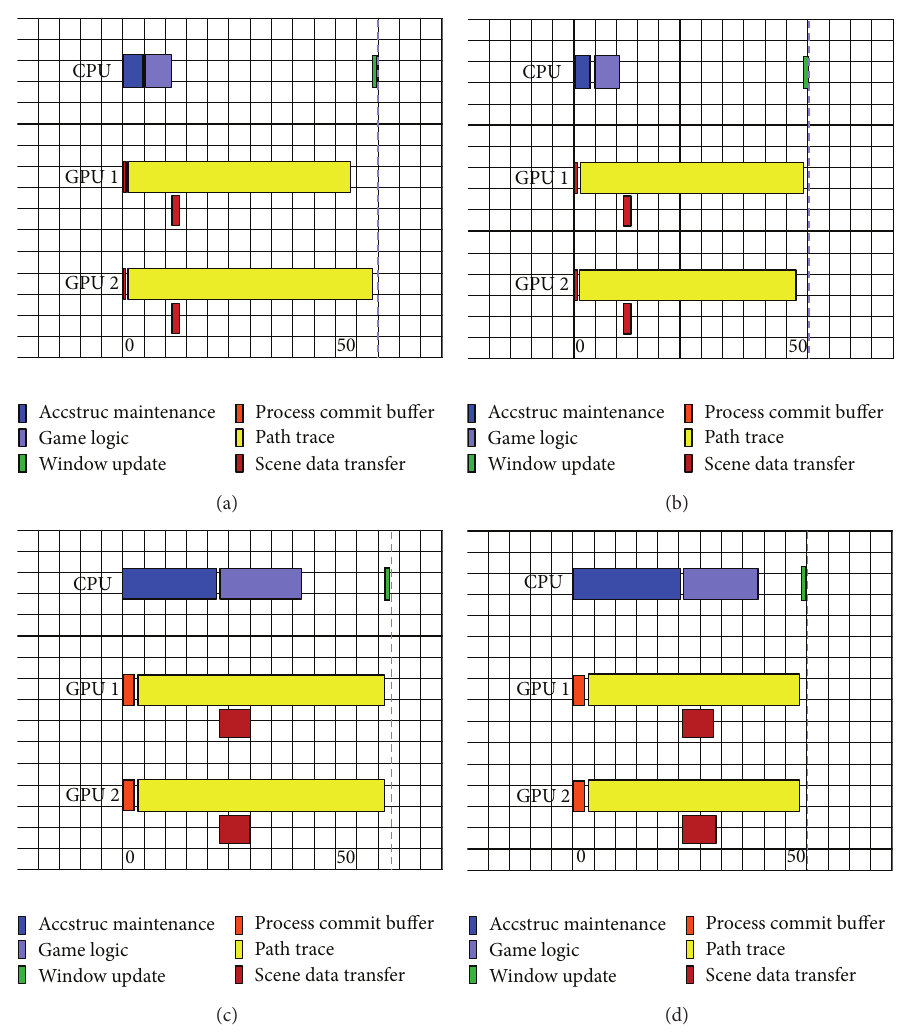
Figure 12: System utilization for the four views shown in Figure